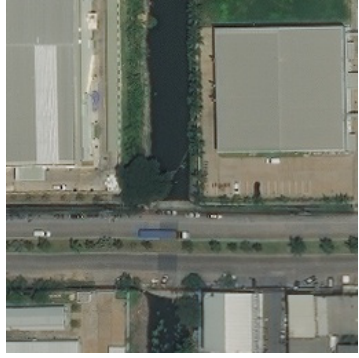
Figure 16. The image in CC dataset .